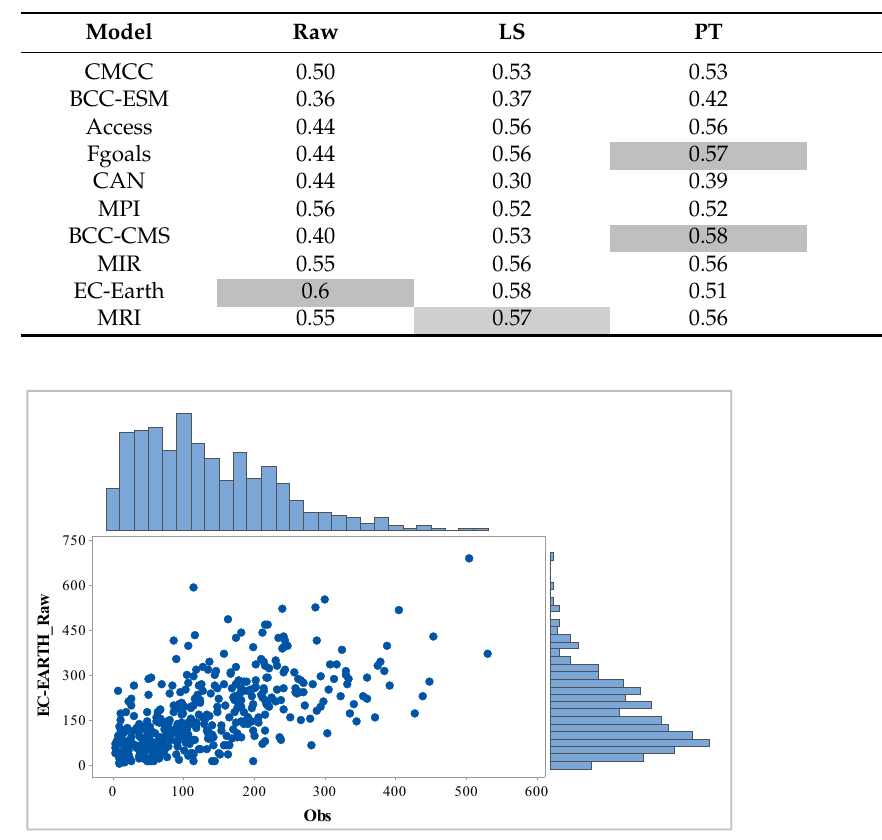
Figure 4. Marginal plot between reference precipitation monthly time series (OBS) and raw EC-Earth data.